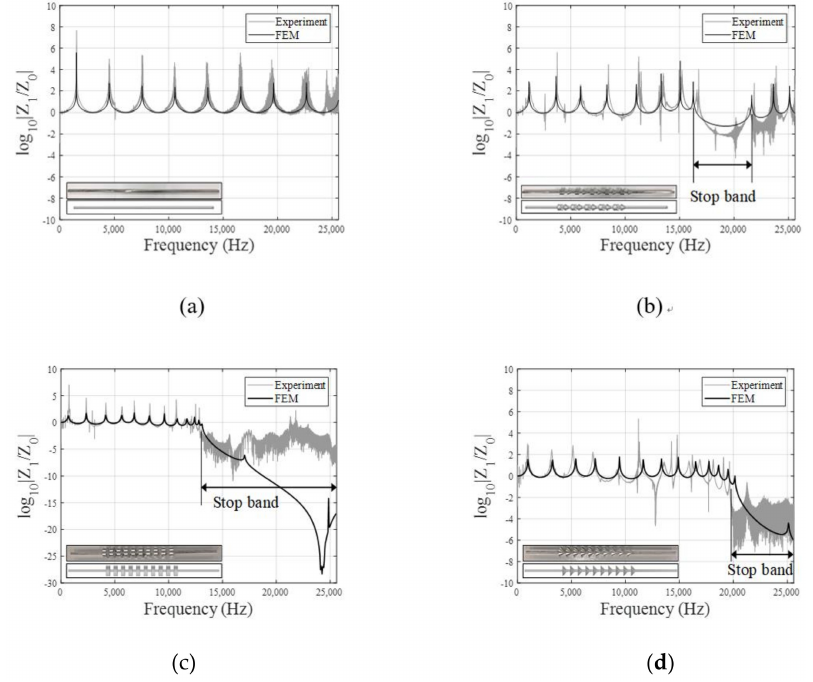
Figure 22. Experiment and analysis results of ( a ) general bar without any other additional shape, ( b ) bar that includes cylinder and conical shape, ( c ) bar that includes cylinder shape and ( d ) bar that includes cone